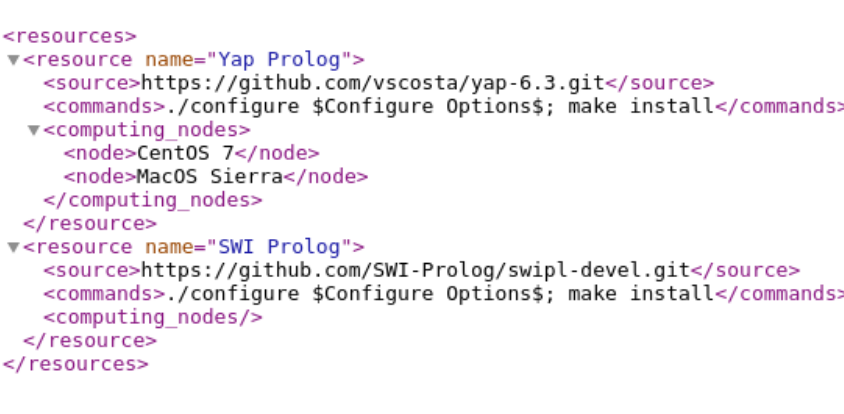
Figure 9. Installing the Yap Prolog resource in the CentOS 7 and MacOS Sierra computing